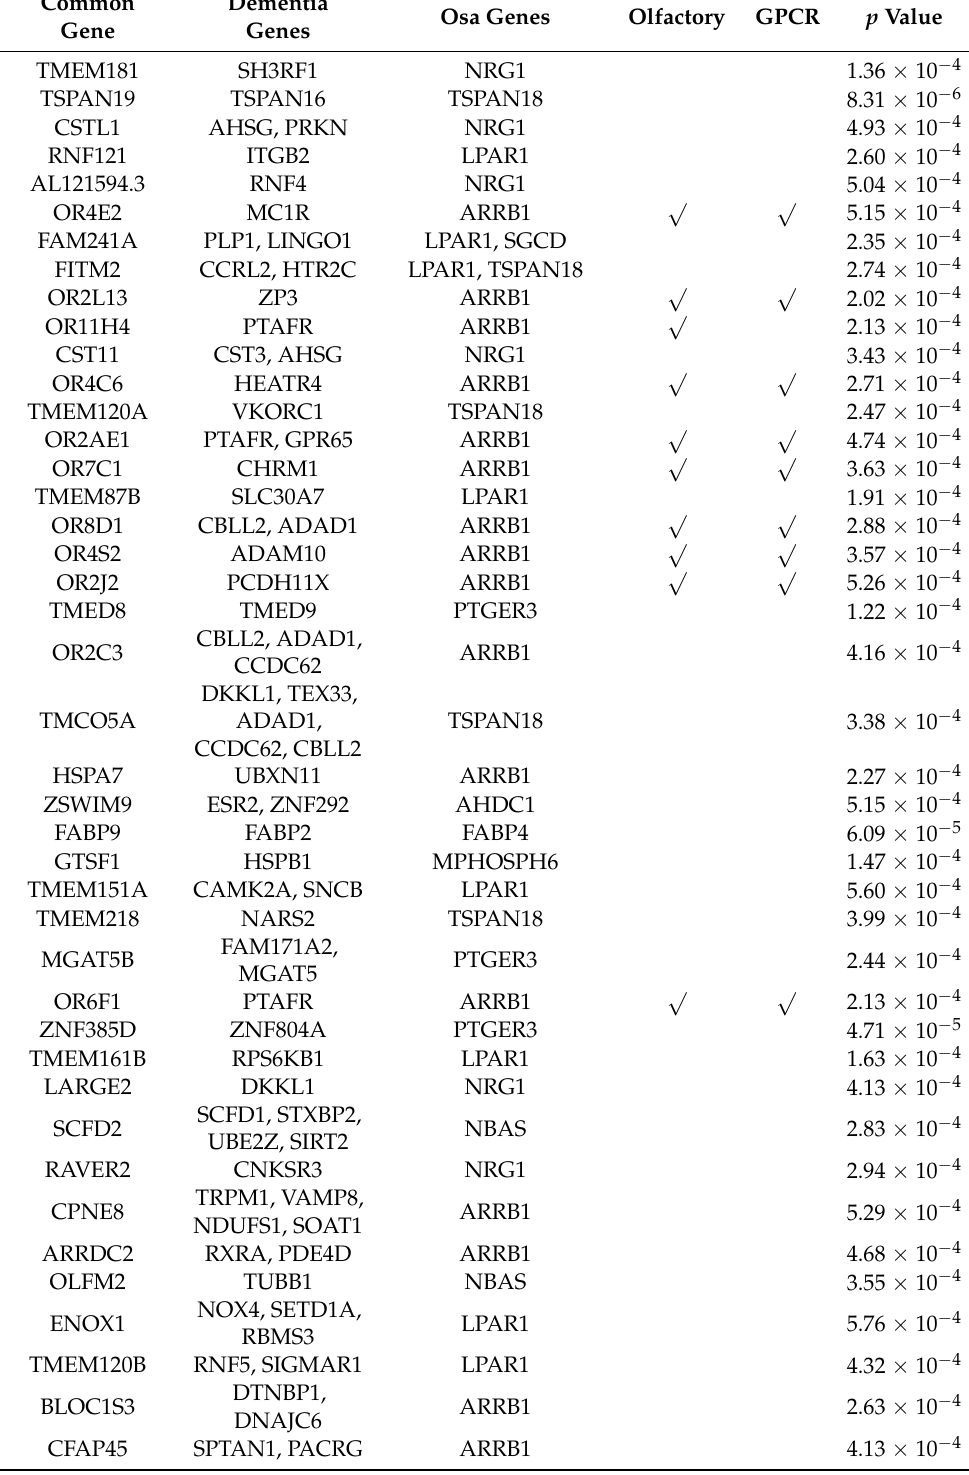
Table 2. The list of common driver genes identified by